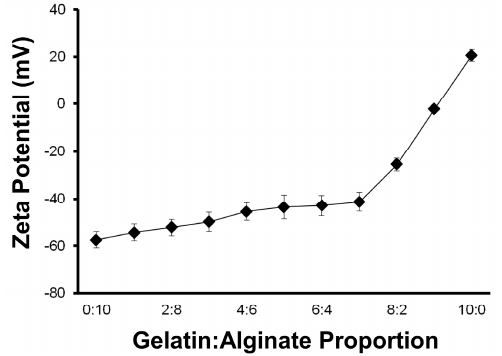
Figure 2. Zeta potential of polymer solutions composed of salmon gelatin and sodium alginate.